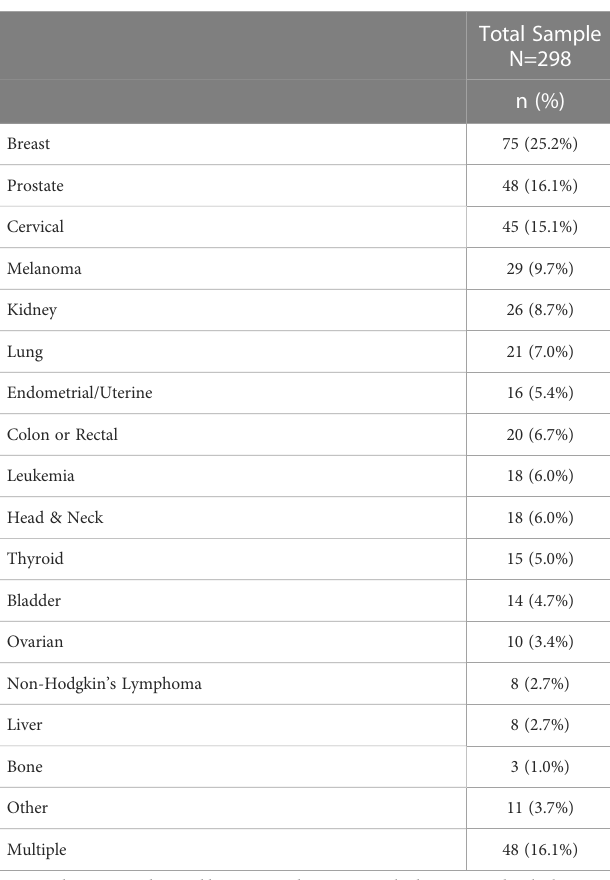
TABLE 2 Cancer types reported by current